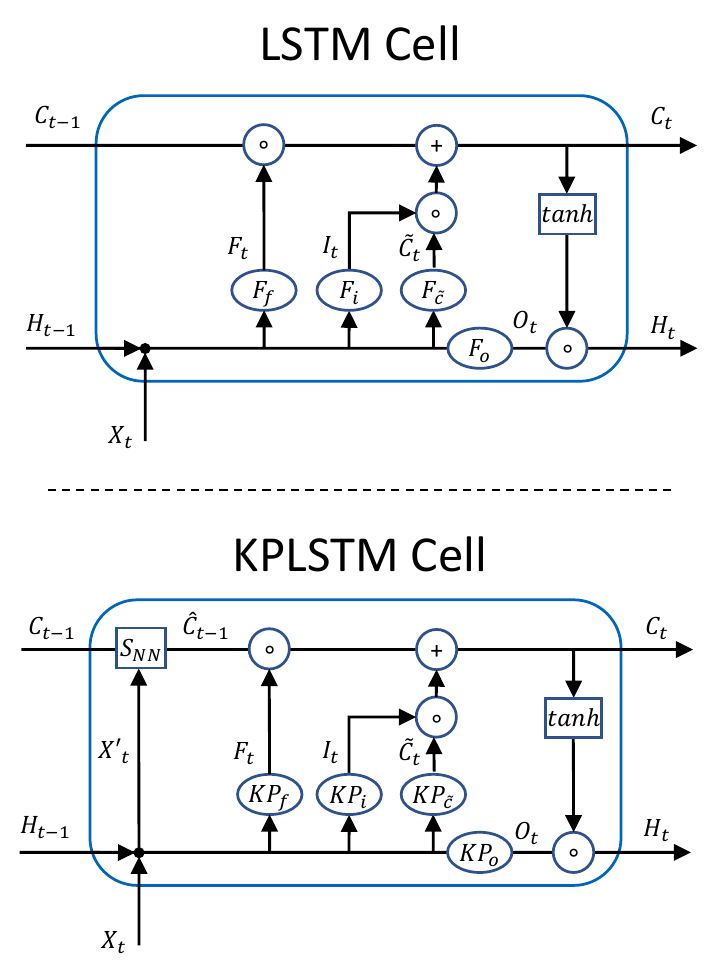
Figure 4. Comparison of standard LSTM cell and KPLSTM cell. The inputs to the LSTM cells are the old cell state C t − 1 , the old hidden state H t − 1 and the current point cloud X t . The output of the cells are the current cell state C t and the current hidden state H t . For the input data, the old hidden state and current point cloud are concatenated. This structure is the same as in the standard LSTM cell. Instead of fully connected layers, KPConv operations KP x are used to model the input gate I t , output gate O t , forget gate F t and internal cell state ˜ C t . The subscript x denotes the respective weights. The KP x layers perform feature generation and point cloud association of the old and current coordinates at the same time. Additionally, the old cell state C t − 1 needs to be mapped to the new point coordinates. As we do not want to apply the features of the new point cloud but only propagate the old features to new coordinates, we take the current point coordinates without the point features X (cid:48) and use them as the center points for t